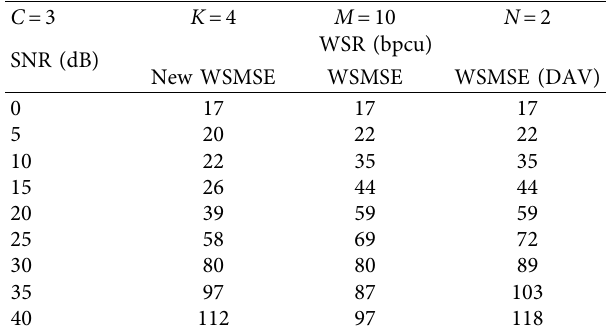
number of Tx antennas is not less than the total number of